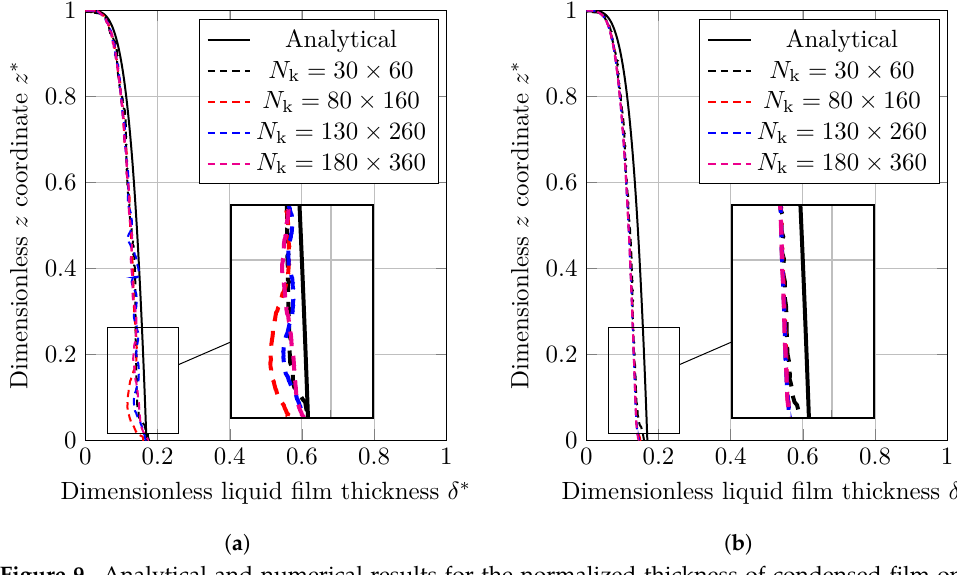
Figure 9. Analytical and numerical results for the normalized thickness of condensed film on a vertical plate predicated using ( a ) VOF and ( b ) CLSVOF.